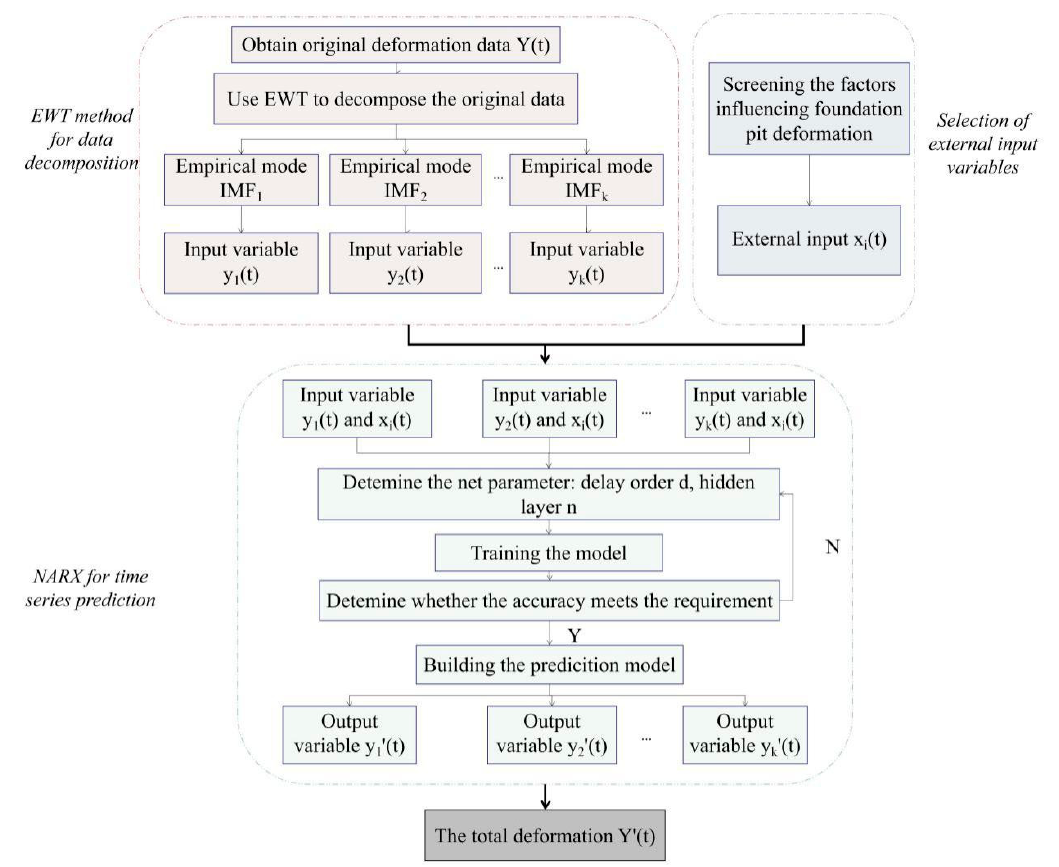
Figure 3. Flow chart of the EWT-NARX foundation pit deformation prediction.